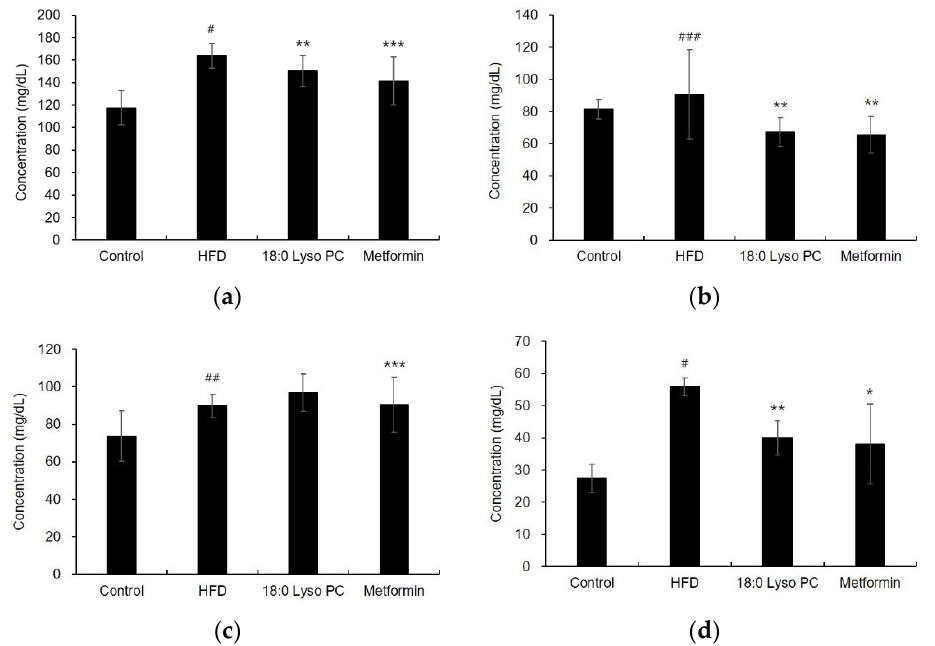
Figure 4. Effect of 18:0 Lyso PC on biochemical parameters in serum of high-fat diet-fed mice: the concentrations of ( a ) total cholesterol, ( b ) triglycerides, ( c ) high-density lipoprotein cholesterol, ( d ) calculated-low-density lipoprotein cholesterol. The results are presented as mean ± SD ( n = 6). Significant differences were identified at # p < 0.005, ## p < 0.05, and ### p < 0.5, the control group vs. the high-fat diet (HFD) group; * p < 0.005, ** p < 0.05, and *** p < 0.5, the HFD group vs. the treatment group.